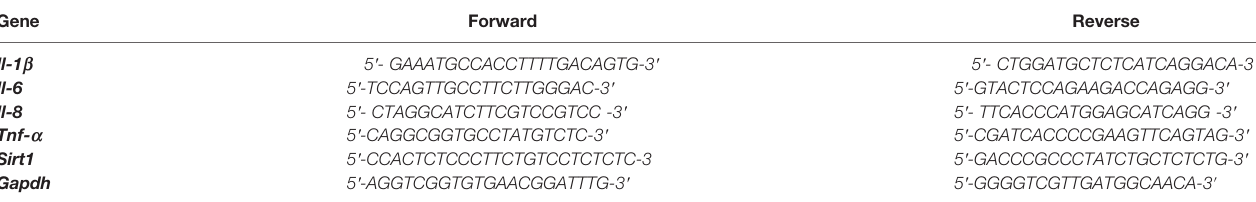
TABLE 1 | Primer sequences used for quantitative